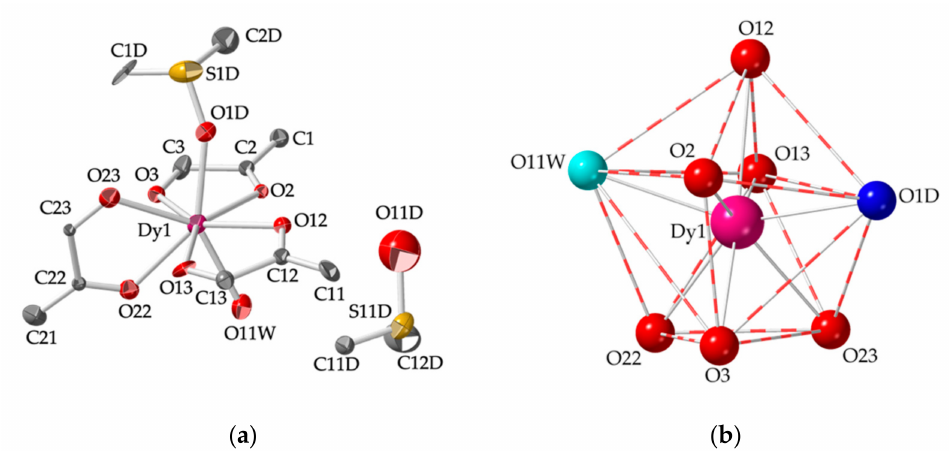
Figure 1. ( a ) Asymmetric unit of compound 1 with the labelling scheme (ellipsoids drawn at 50% probability). H atoms and the crystallization water molecule have been omitted for clarity; ( b ) Coordination environment of the Dy(III) ion in compound 1 . The O atom of the coordinated dmso and water molecules are drawn in dark and light blue,